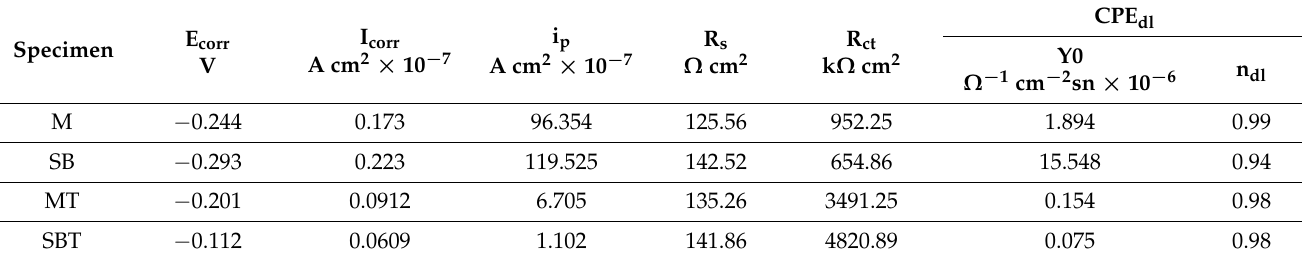
Table 4. Electrochemical parameters extracted from the corrosion tests in Hank’s